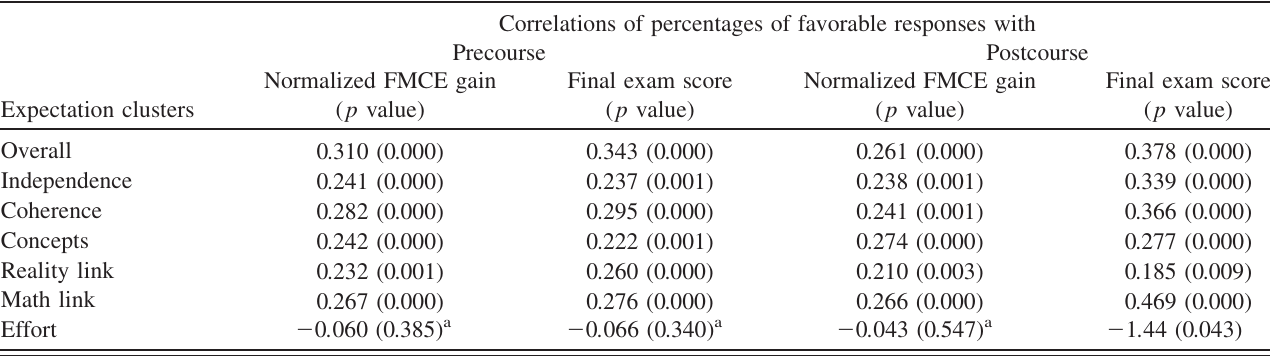
TABLE IX. Pearson-r correlation coefficients between students’ percentages of favorable responses (precourse and postcourse MPEX scores in 2007) and